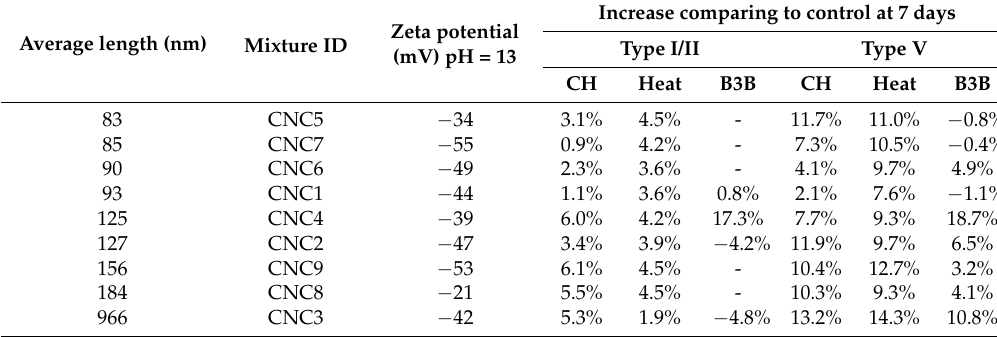
Table 5. Effect of different CNC on CH content, heat release and B3B flexural strength.